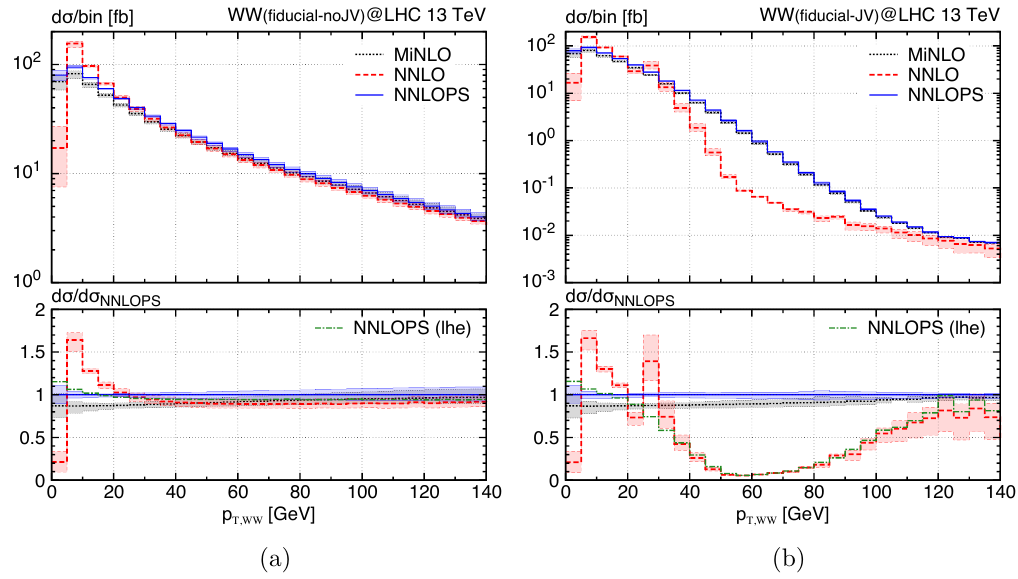
Figure 8 . Same as (cid:12)gure 7, but for the distribution in the transverse momentum of the colourless (cid:12)nal-state system; (a) fiducial-noJV and (b) fiducial-JV phase